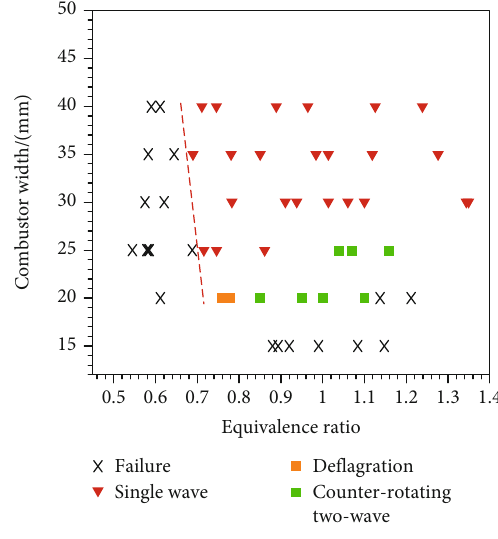
Figure 3: Operating